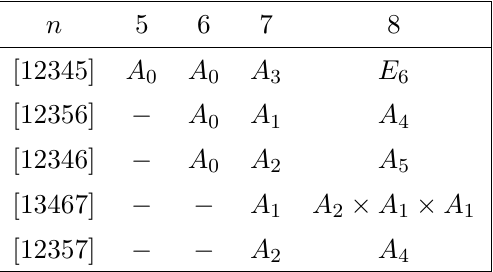
Table 3. Various R-invariants and their subalgebras in Conf n ( P 3 ) at di(cid:11)erent multiplicities n